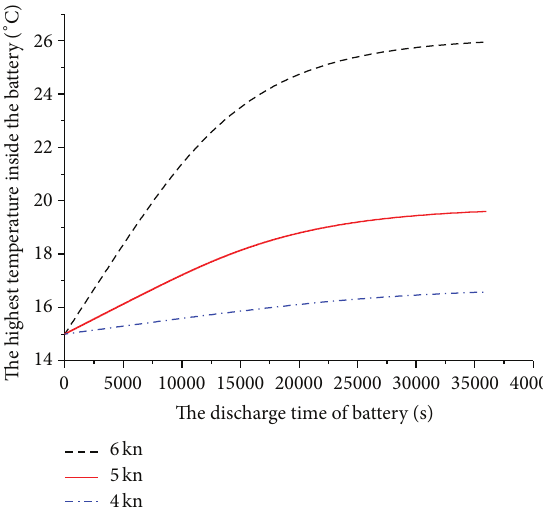
Figure 9: The maximum temperature changes over